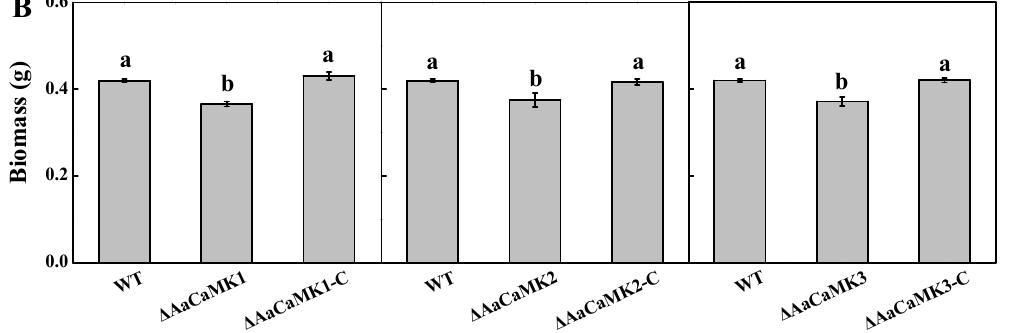
Figure 2. The sporulation rate ( A ) and biomass ( B ) of A. alternata on PDA medium 5 d after incubation at 28 °C. Bars indicate standard error (±SE). Different letters indicate significant differences ( p < 0.05).